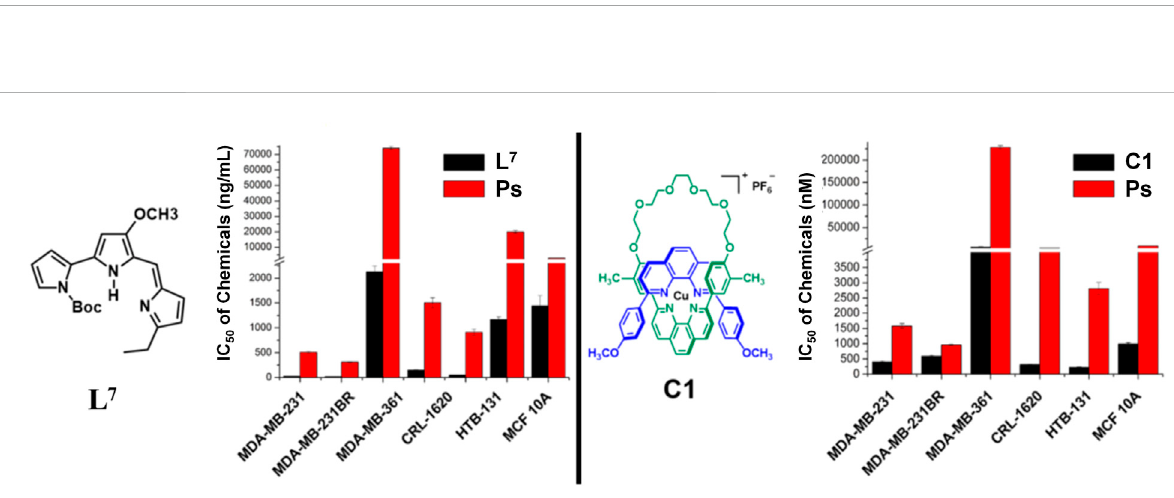
FIGURE 4 Anticancer activitiesofcompounds L 7 and C1 .The lowertheIC 50 ,thehighertheactivityis.Bothcompoundsshowextremelyhigheranticancer activity than native drug, Ps